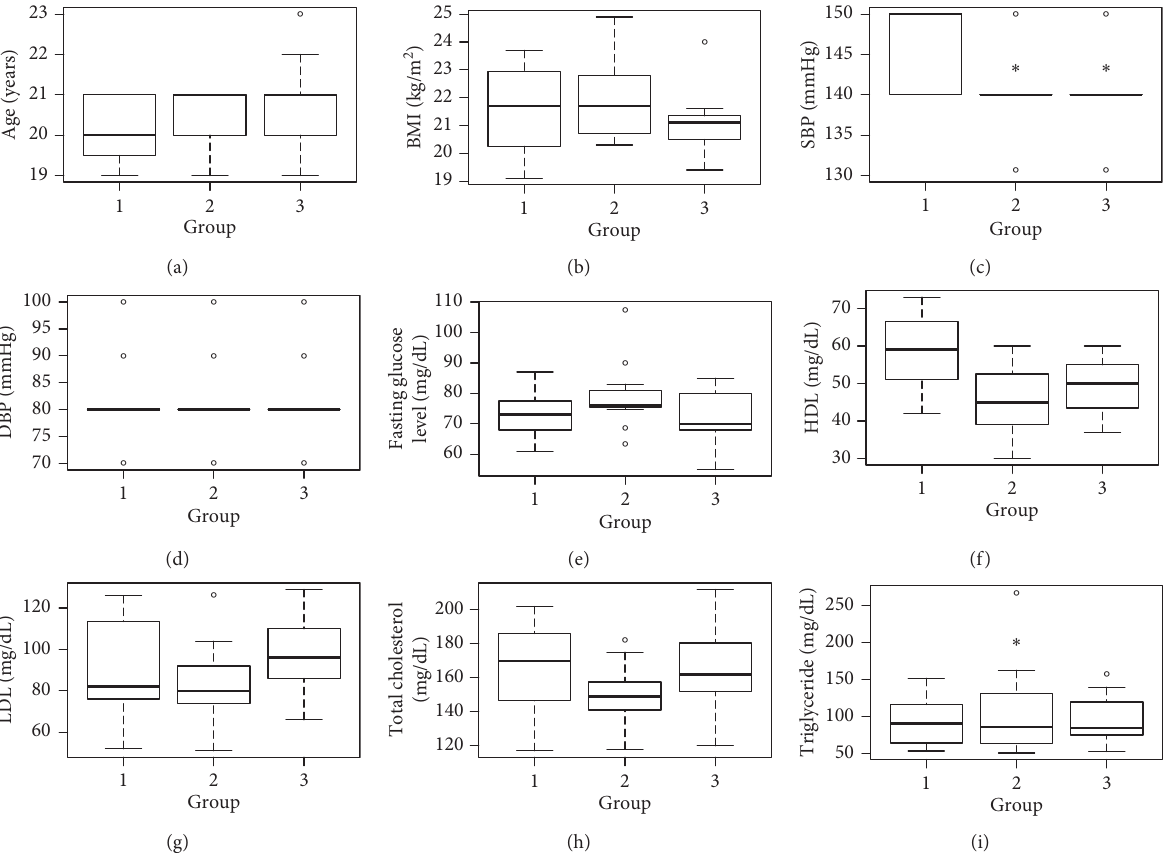
Figure 1: Box-plot model for the differences between groups. (1) High-intensity exercise; (2) moderate-intensity exercise; and (3) moderate- intensity exercise+music. ∗ Significant vs high-intensity exercise ( p ≤ 0 .